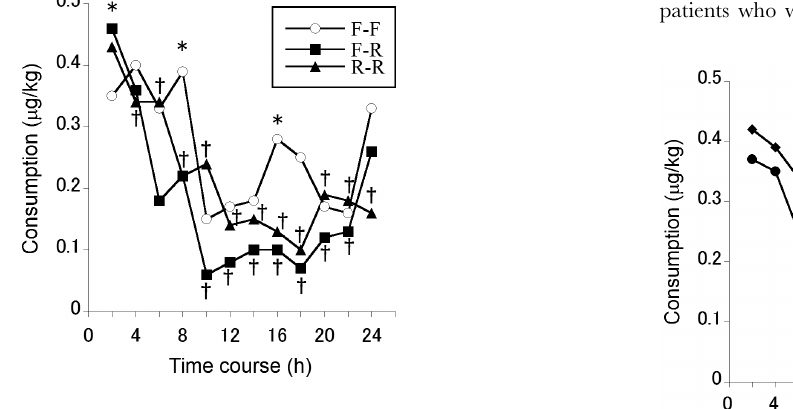
Figure 2. Differences in the time course of fentanyl adminis- tration among anesthesia methods. Main effects, interactions, and differences within time courses were analyzed using mixed-design ANOVA (one-way for independent groups and repeated-measures with Huynh-Feldt correction). F-F, fentanyl induction followed by fentanyl maintenance; F-R, fentanyl induction followed by remifentanil mainte- nance; R-R, remifentanil induction followed by remifentanil mainte- nance. The values indicate the medians. { P , 0.05, compared with fentanyl consumption in the first 2 h; * P , 0.05, significant difference among the three groups in 2 h fentanyl consumption.